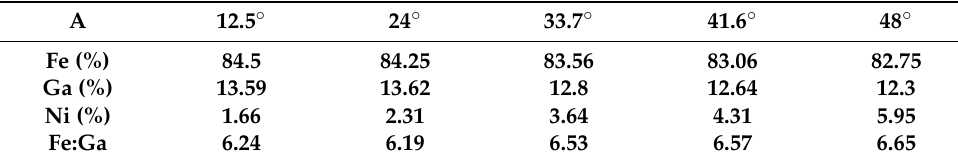
Figure 3. Crystallite size of FeGa and FeGaNi films calculated by Scherrer’s law with FWHM of (110) peak. Table 2. Chemical composition of FeGaNi film with α .